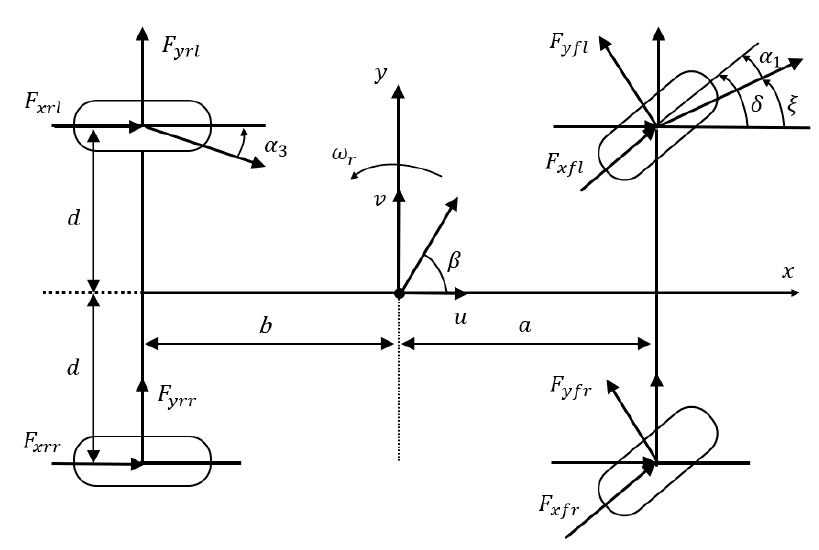
Figure 3. Controller system structure.